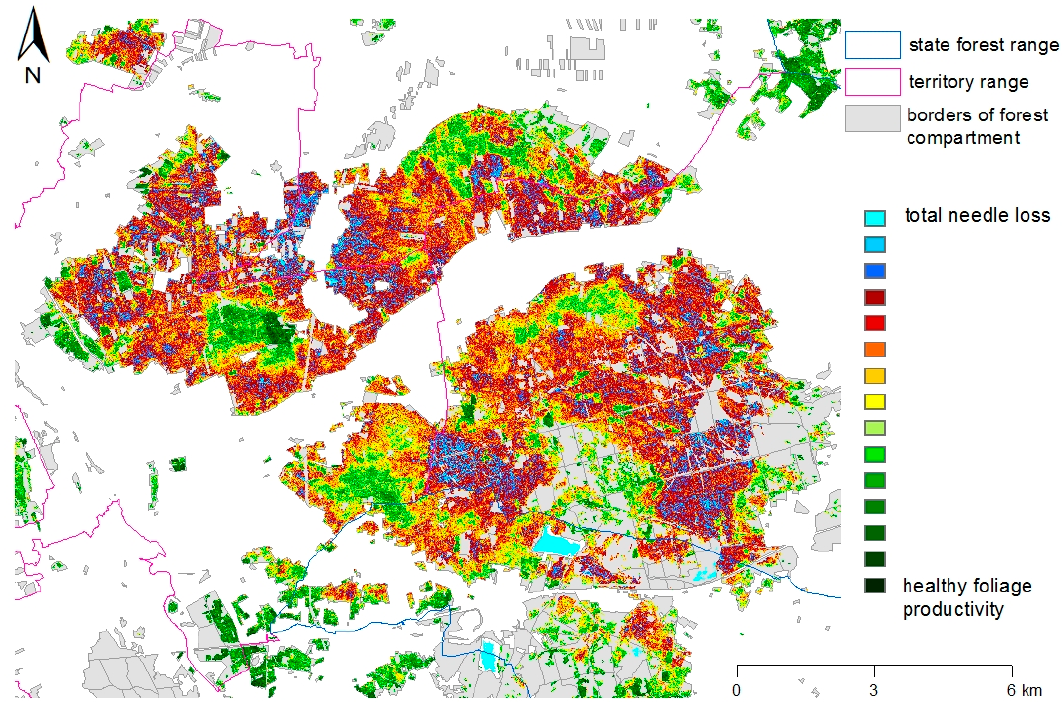
Figure 4. Satellite data by the RapidEye sensor used for identification of areas with feeding damages by sawfly larvae documented as the spatial differences in foliage productivity (from healthy—green—over yellow, orange, red, blue to light blue—total needle loss), autumn 2016 (Planet Labs, Inc.). For orientation, see Figures 1b and 3.